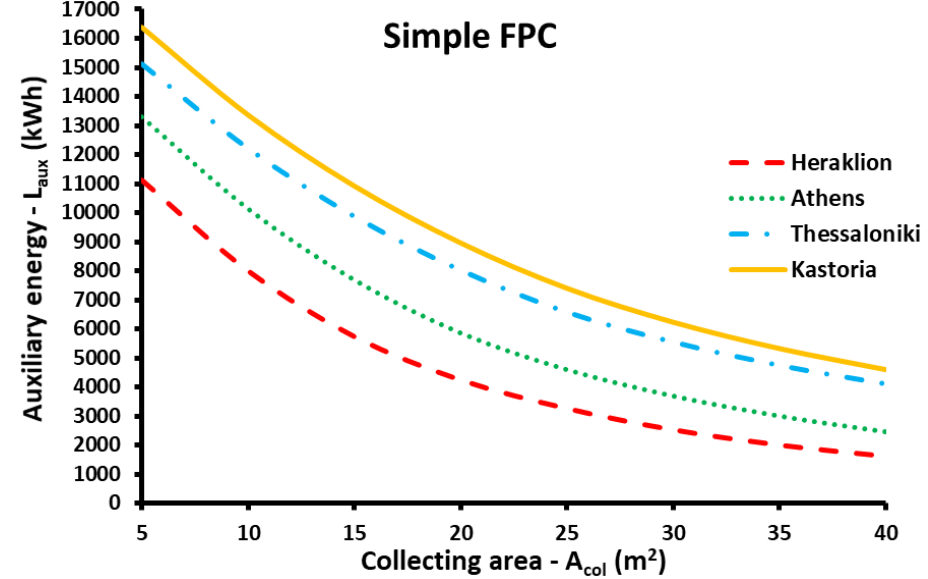
Figure 16. Auxiliary energy consumption with optimum tilt angles for simple FPC.